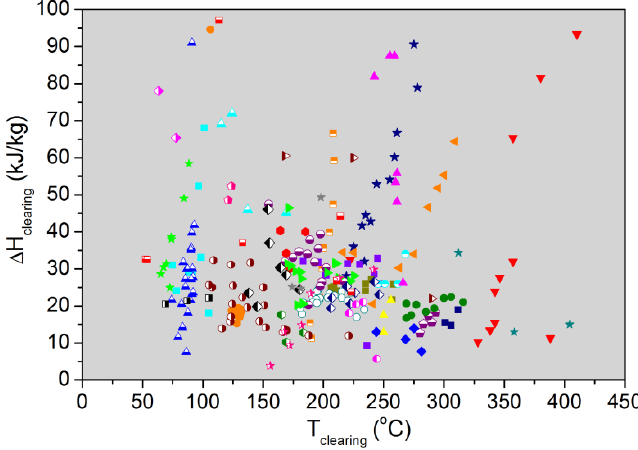
Figure 1. Clearing point enthalpy vs. clearing point temperature for various reported liquid crystals with properties in the desired range for latent thermal storage.